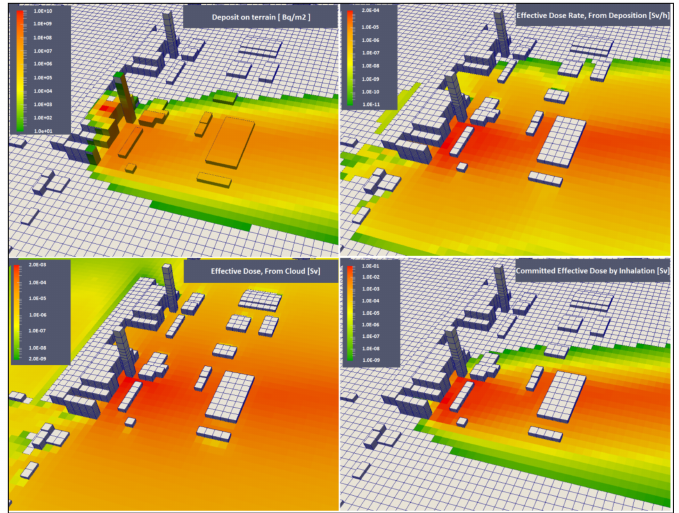
Figure 2. Example of an impact calculation for an urban environment—a release from the reactor building of the Mochovce NPP is simulated). Deposit on surfaces ( top left ), and effective dose rate from deposition ( top right ), from cloud ( bottom left ), and by inhalation ( bottom right ) are